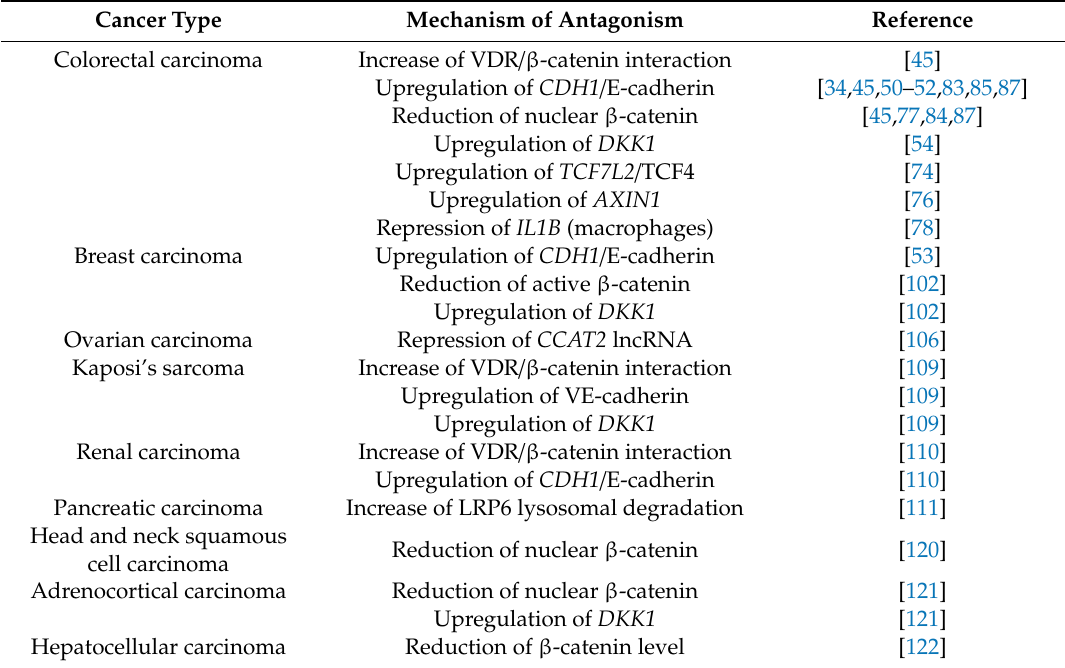
Table 1. Mechanisms of Wnt / β -catenin pathway interference by 1,25(OH) 2 D 3 in solid